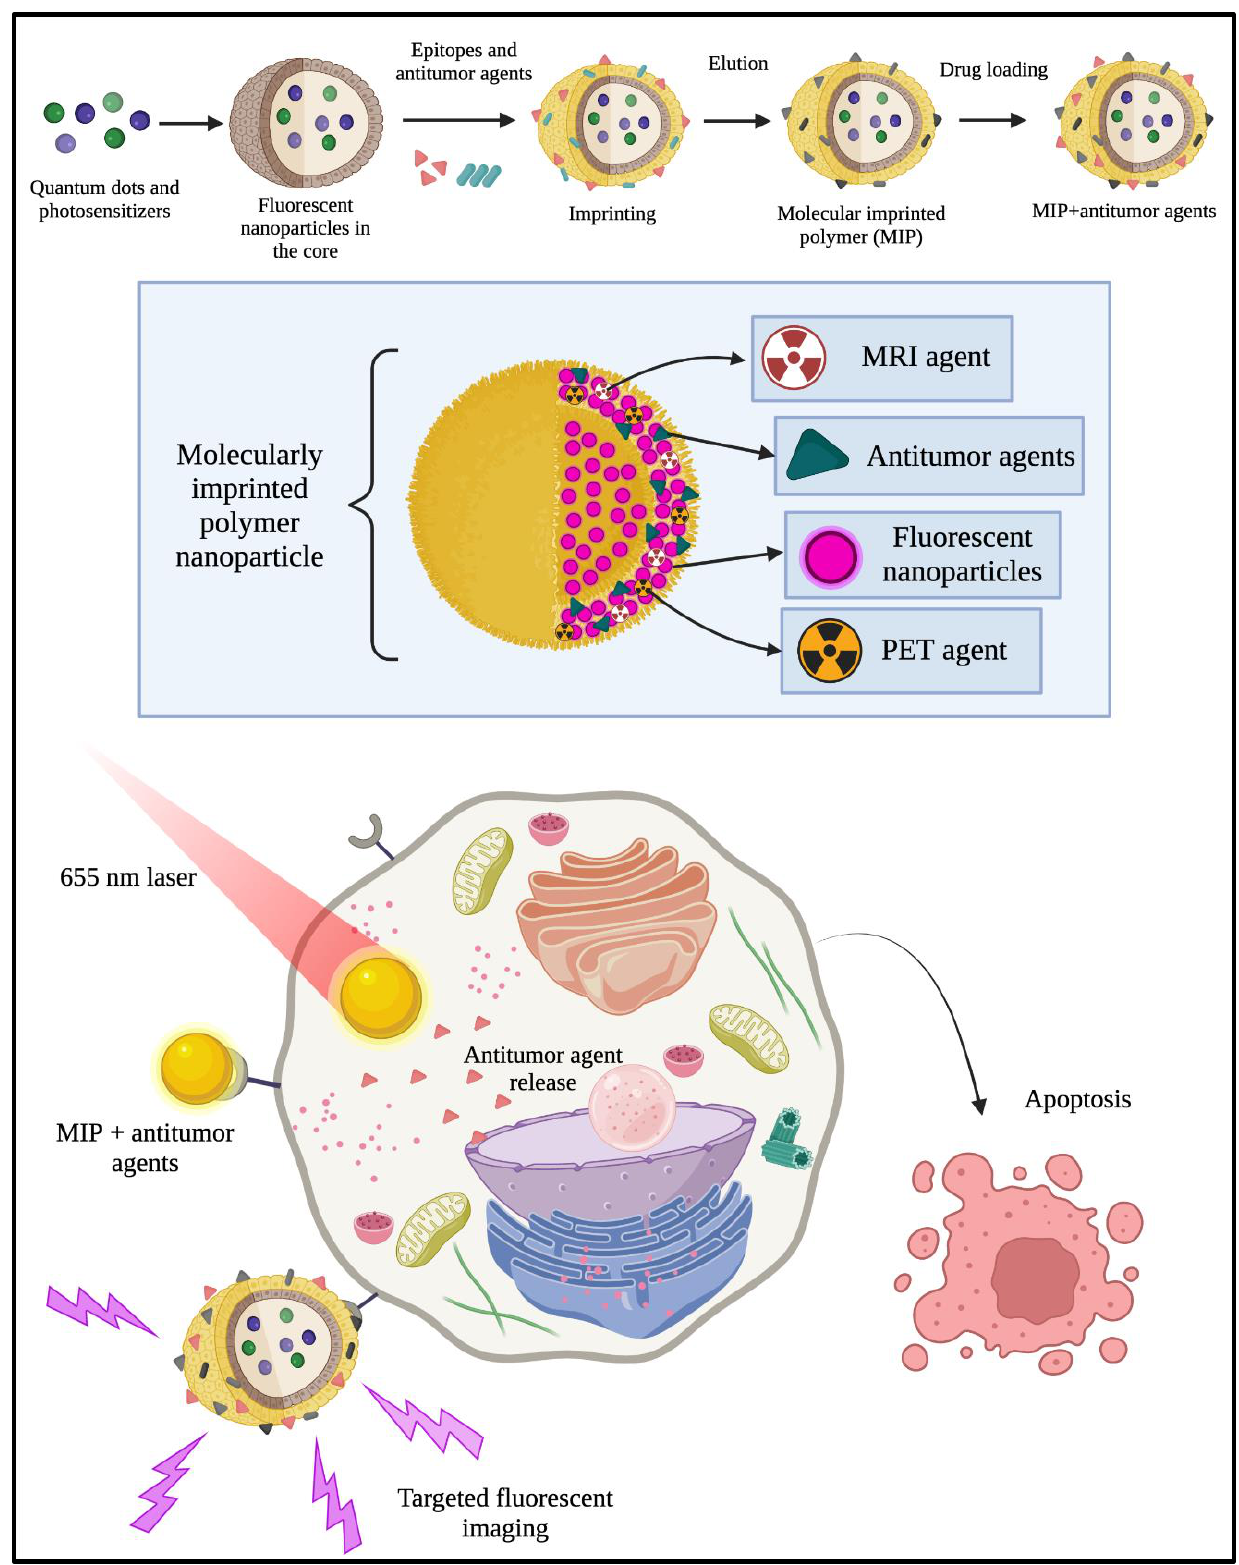
Figure 3. Synthesis of molecularly imprinted polymers encapsulating quantum dots, photosensitizers, MRI contrast agents, and antitumor agents. Such multifunctional loaded MIP particles, when engulfed by the cancer cells and exposed to a laser, leads to activation of apoptosis or programmed cell death and other cascades, finally causing the death of the cancer cells.